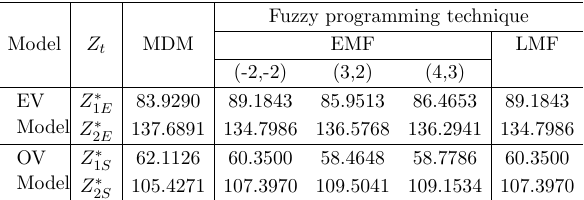
Table 5. Comparison of the results obtained with two